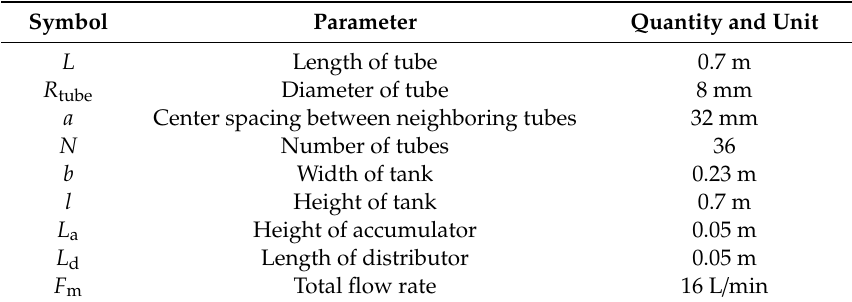
Table 1. Parameters of the tube-tank heat exchanger and